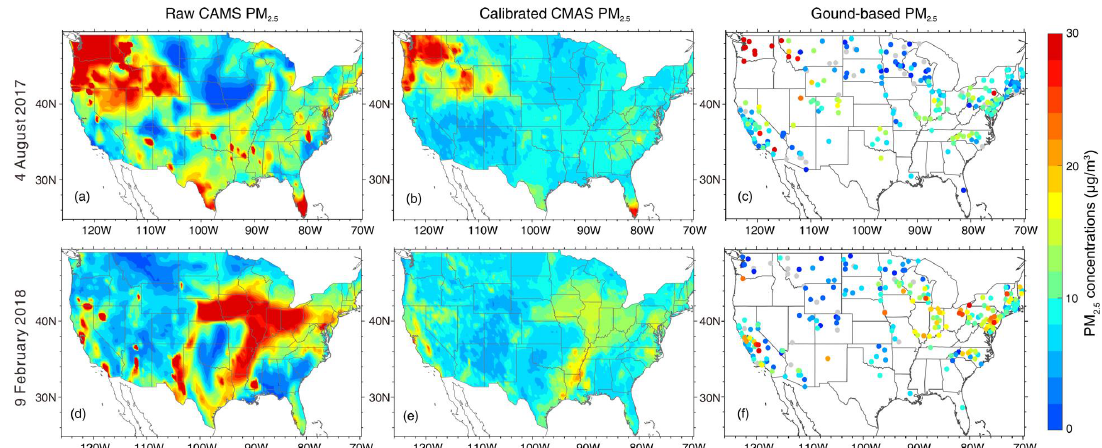
Figure 11. Comparisons of CMAS PM 2.5 forecasts with a forecasting time horizon of 3 h (step-3) before ( a , d ) and after ( b , e ) the calibration in US on two di ff erent days. ( c , f ) Show the in situ PM 2.5 measurements on the corresponding date.